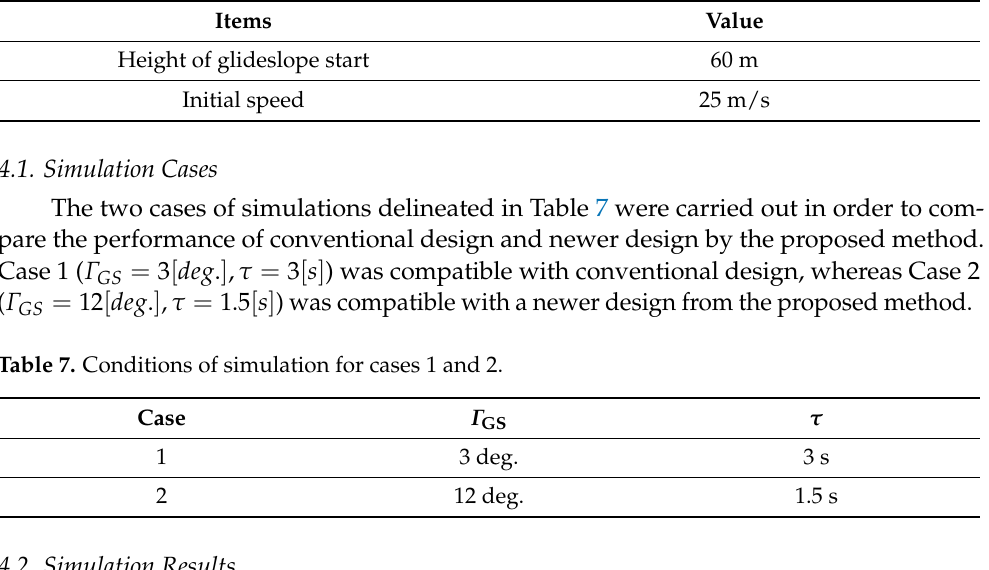
Table 6. Simulation conditions.